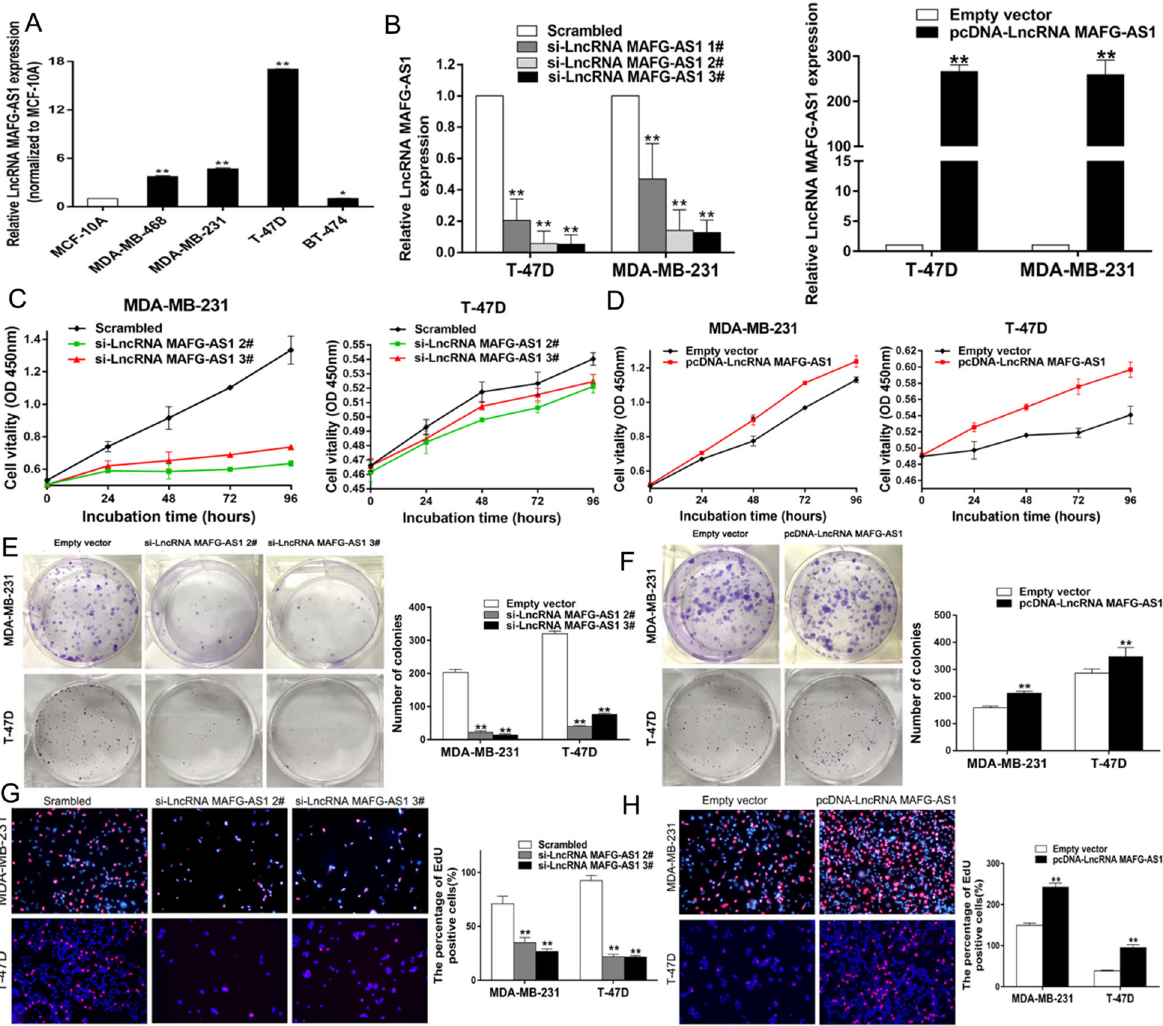
Fig. 2 LncRNA MAFG-AS1 promotes BC cell-proliferation in vitro. A q RT-PCR assay examined LncRNA MAFG-AS1 expression in normal breast epithelial cell line (MCF-10A) and BC cell lines. B Left: qRT-PCR analysis of LncRNA MAFG-AS1 expression in BC cells transfected with control (scrambled), si-LncRNA MAFG-AS11#, 2#,3#. Right: Relative expression of LncRNA MAFG-AS1 in BC cells transfected with empty vector and pcDNA-LncRNA MAFG-AS1. C , D CCK-8 assays were performed to determine the viability of BC cells treated with si-LncRNA MAFG-AS1 or pcDNA-LncRNA MAFG-AS1. E , F Colony formation assays were used to detect the proliferation of si-LncRNA MAFG-AS1 or pcDNA-LncRNA MAFG-AS1-transfected BC cells and colonies were counted and captured. G , H Proliferous BC cells were displayed by EdU immunostaining assays. EdU positive cells were counted and captured. Values are shown as the mean ± s.d in three independent experiments. * P < 0.05, ** P <